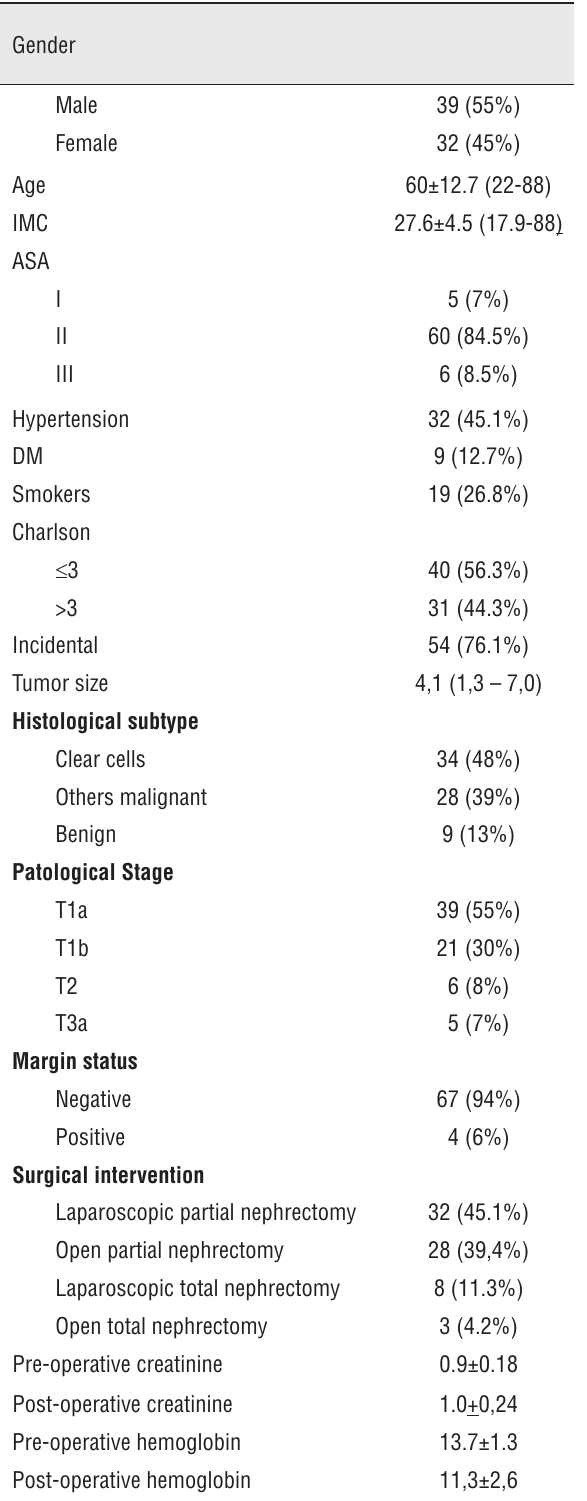
Table 1 - clinicopathological data and surgical